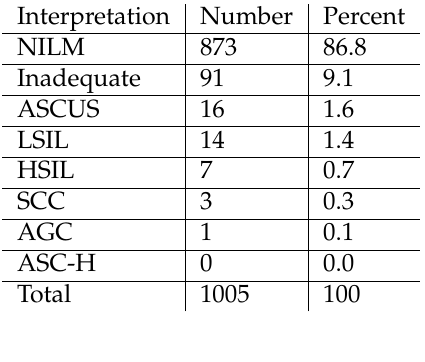
Table 5. Frequency of distribution of various interpretations on Pap